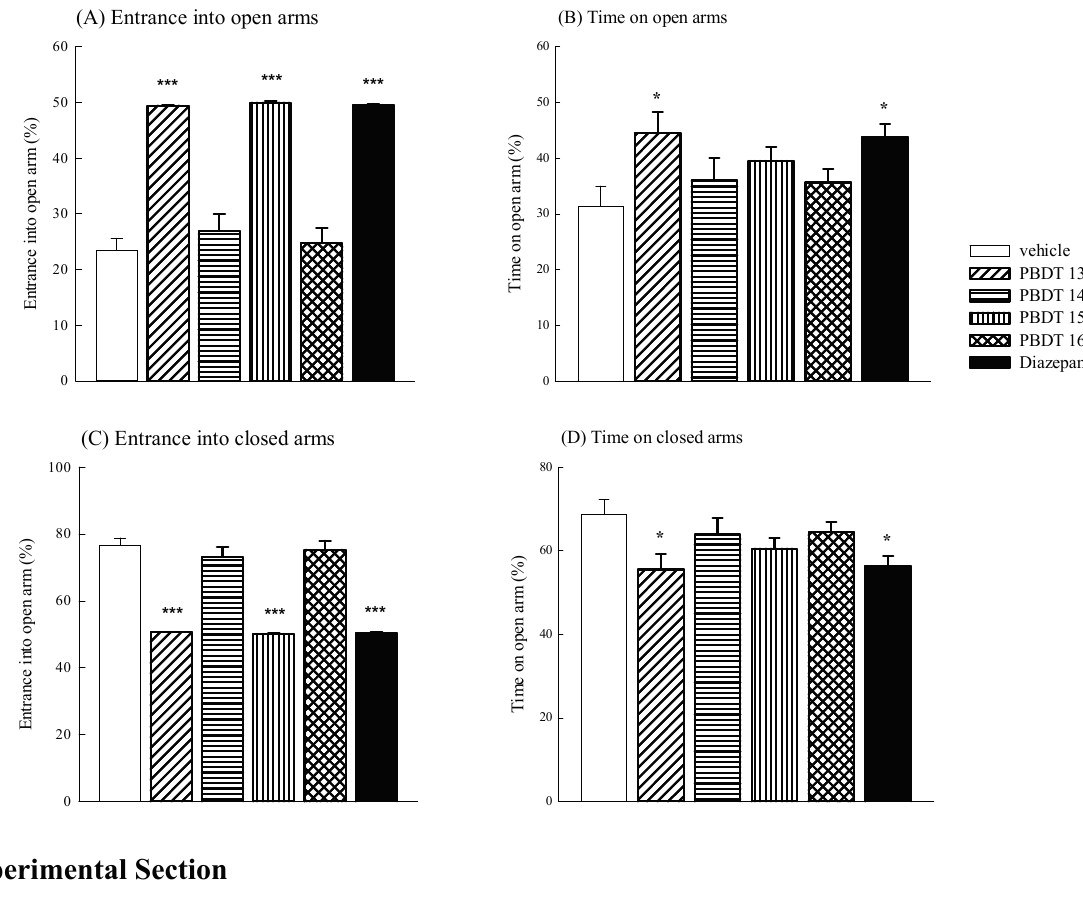
Figure 3. The effects of PBDTs 13 – 16 (1 mg/kg, ip) or diazepam (1 mg/kg, ip) on the ( A ) the percentage of open arm entries; ( B ) the percentage of time spent in open arm entries; ( C ) the percentage of closed arm entries and ( D ) the percentage of time spent in the closed arm entries of the elevated pus maze during a 5-min test in male mice. Values are the mean ± SEM, n = 4 mice; * p < 0.05, *** p < 0.001, compared with the vehicle